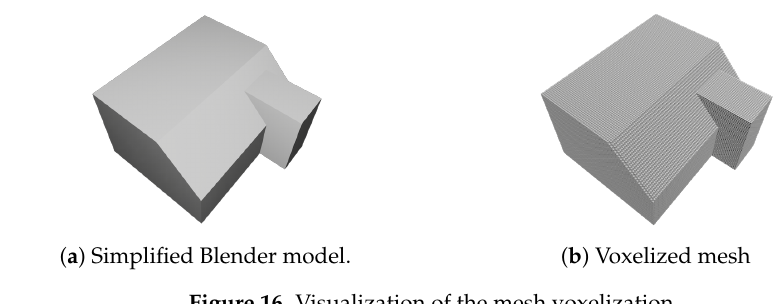
Figure 16. Visualization of the mesh